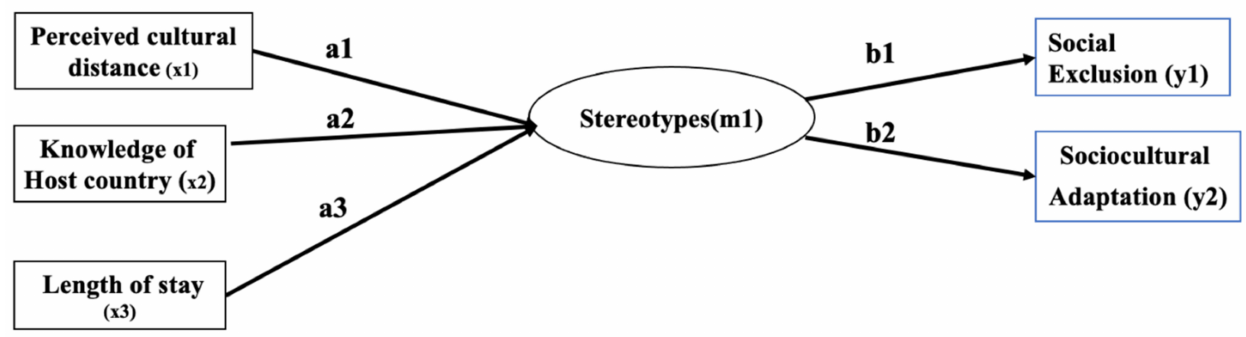
Figure 2. Theorized mediation model, where Xs are the predictors, M is the mediator and Ys are the outcome